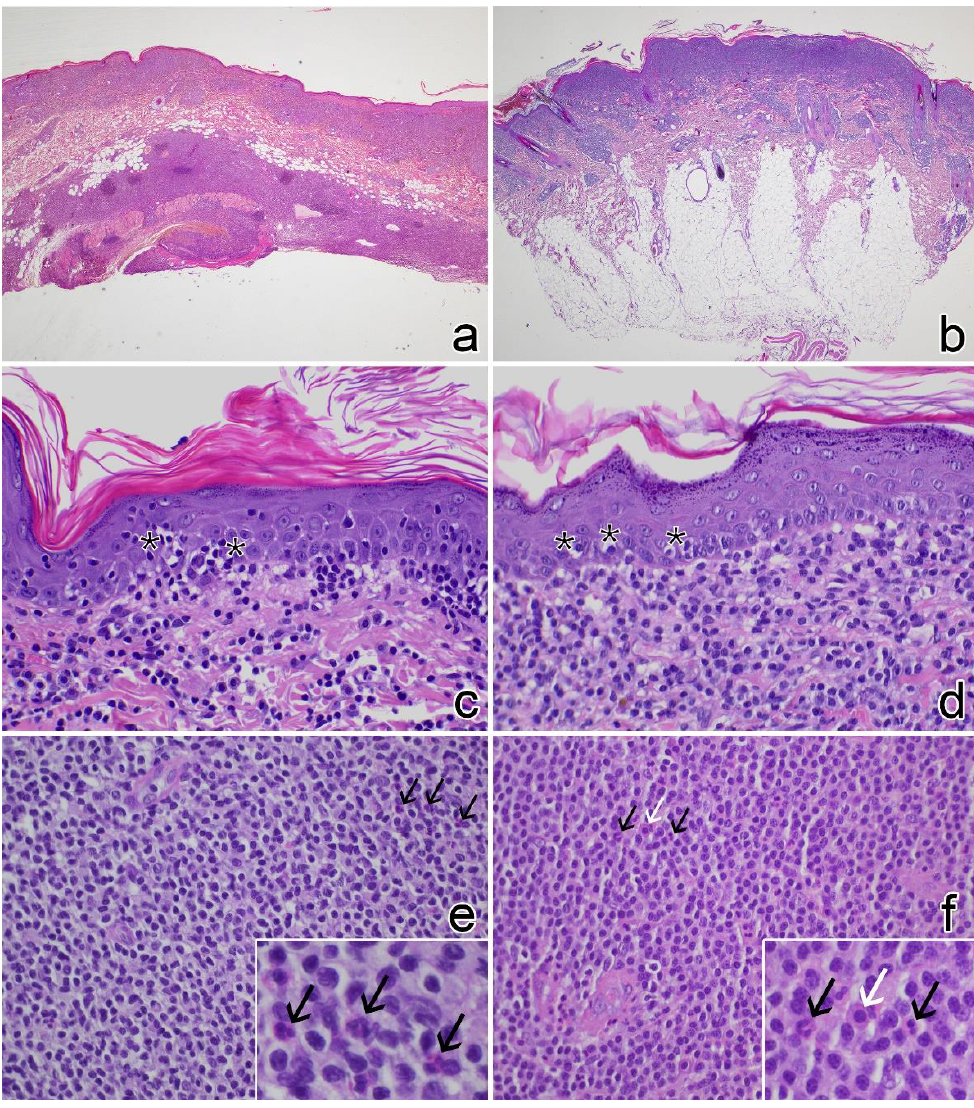
Figure 3. Histological findings in cases of feline and canine cutaneous lymphocytosis (H&E stain). ( a ) Cat no. 3: diffuse lymphocytic infiltrates in the superficial dermis and panniculus, note lymphocyte aggregates in the panniculus (20×). ( b ) Dog no. 6: diffuse lymphocytic infiltrate in the superficial dermis (20×). ( c ) Cat no. 8: mild epitheliotropism by small lymphocyte aggregates (asterisks) (400×). ( d ) Dog no. 4: mild epitheliotropism by single lymphocytes (asterisks) (400×). ( e ) Cat no. 3: diffuse infiltrate of small lymphocytes with few infiltrating eosinophils (black arrows in the figure and in the inset) (400×). ( f ) Cat no. 7: diffuse infiltrate of small lymphocytes with few infiltrating mast cells (white arrow in the figure and in the inset) and eosinophils (black arrows in the figure and in the inset) (400×).